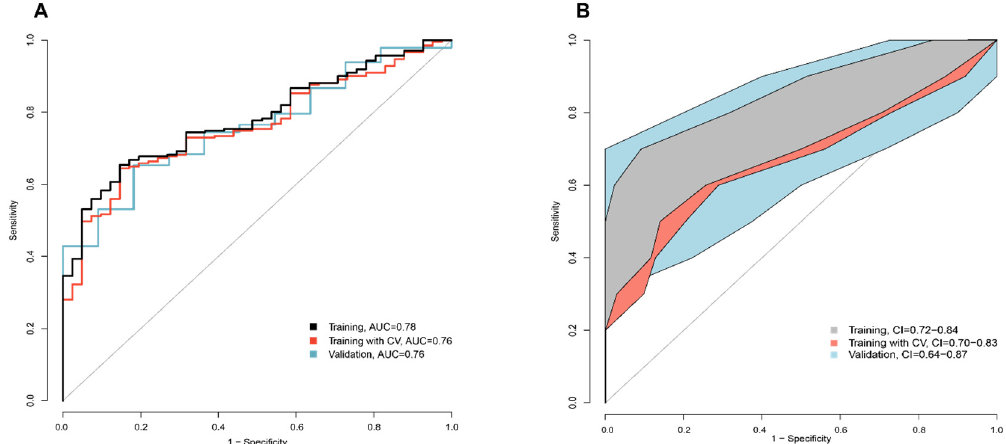
Figure 1. ( A ) ROC curves for the discrimination between asthma patients with recent exacerbations and without exacer- bations; ( B ) 95%-confidence intervals of ROC curves.